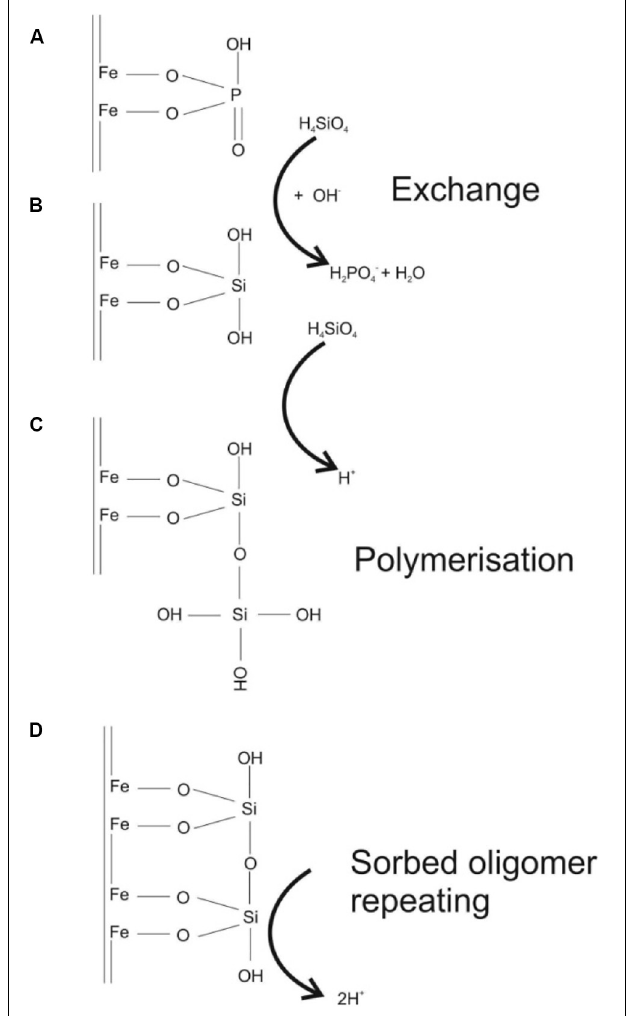
FIGURE 7 | (A,B) substitution of a bidentate phosphate ligand on an iron oxide surface with the siliceous acid bidentate ligand, (C,D) polymerization of the siliceous acid and sorption of the oligomer to the iron oxide surface. Note the dimer shown represents Si-O-Si chains with a minimum length of 3 units. The monomer has seldom been observed in experiments.